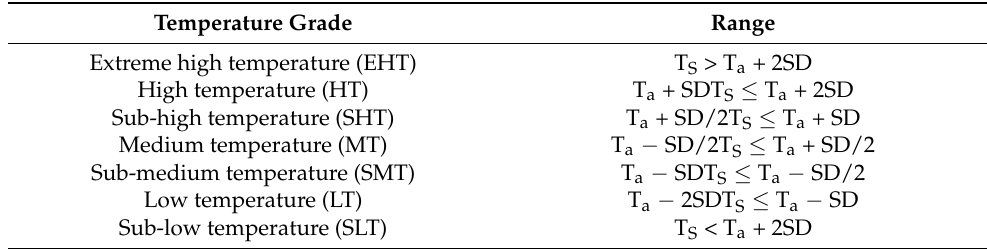
Table 2. Range of LST intervals. T s represents land surface temperature; T a is the average land surface temperature. SD is the standard deviation.